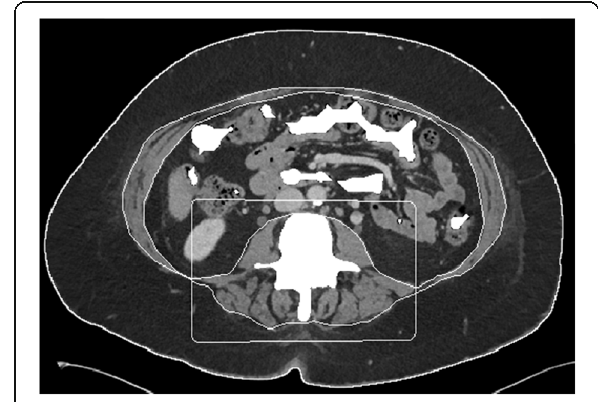
Fig. 2 Segmentation of a computed tomography image of a 57- year-old sarcopenic female with a skeletal muscle index of 33 cm 2 /m 2